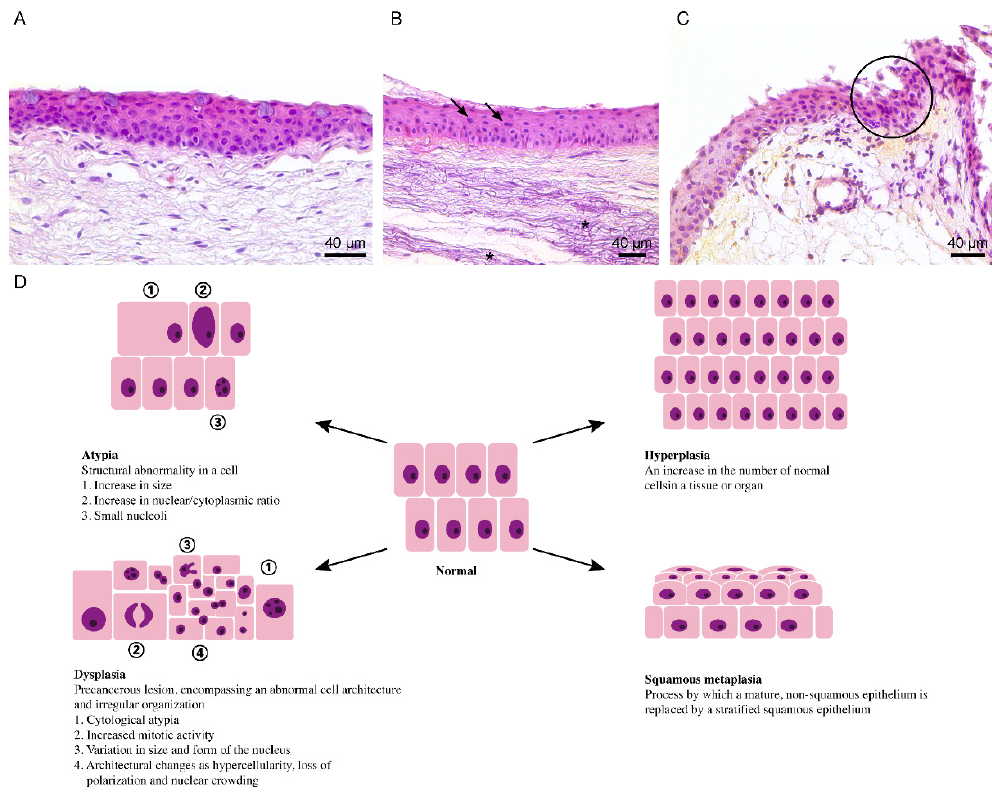
Figure 3. Illustrative hematoxylin and eosin staining of ( A ) a healthy conjunctiva, ( B ) reactive atypia (black arrow) and solar elastosis (asterisk) in pterygium and ( C ) low-graded dysplasia (blue circle) in pterygium, combined with ( D ) a schematic representation of atypia, hyperplasia, squamous metaplasia and dysplasia. Reactive atypia is identified based on the presence of an aberrant cellular morphology, an enhanced nuclear-to-cytoplasmic ratio and a clear nucleolus ( B ). Dysplasia is recognized due to the presence of hyperchromasia, nuclear crowding and hypercellularity ( C ). To aid in distinguishing the cellular adaptations and transformation from one another, definitions and characteristic features are included in the schematic representation ( D ).